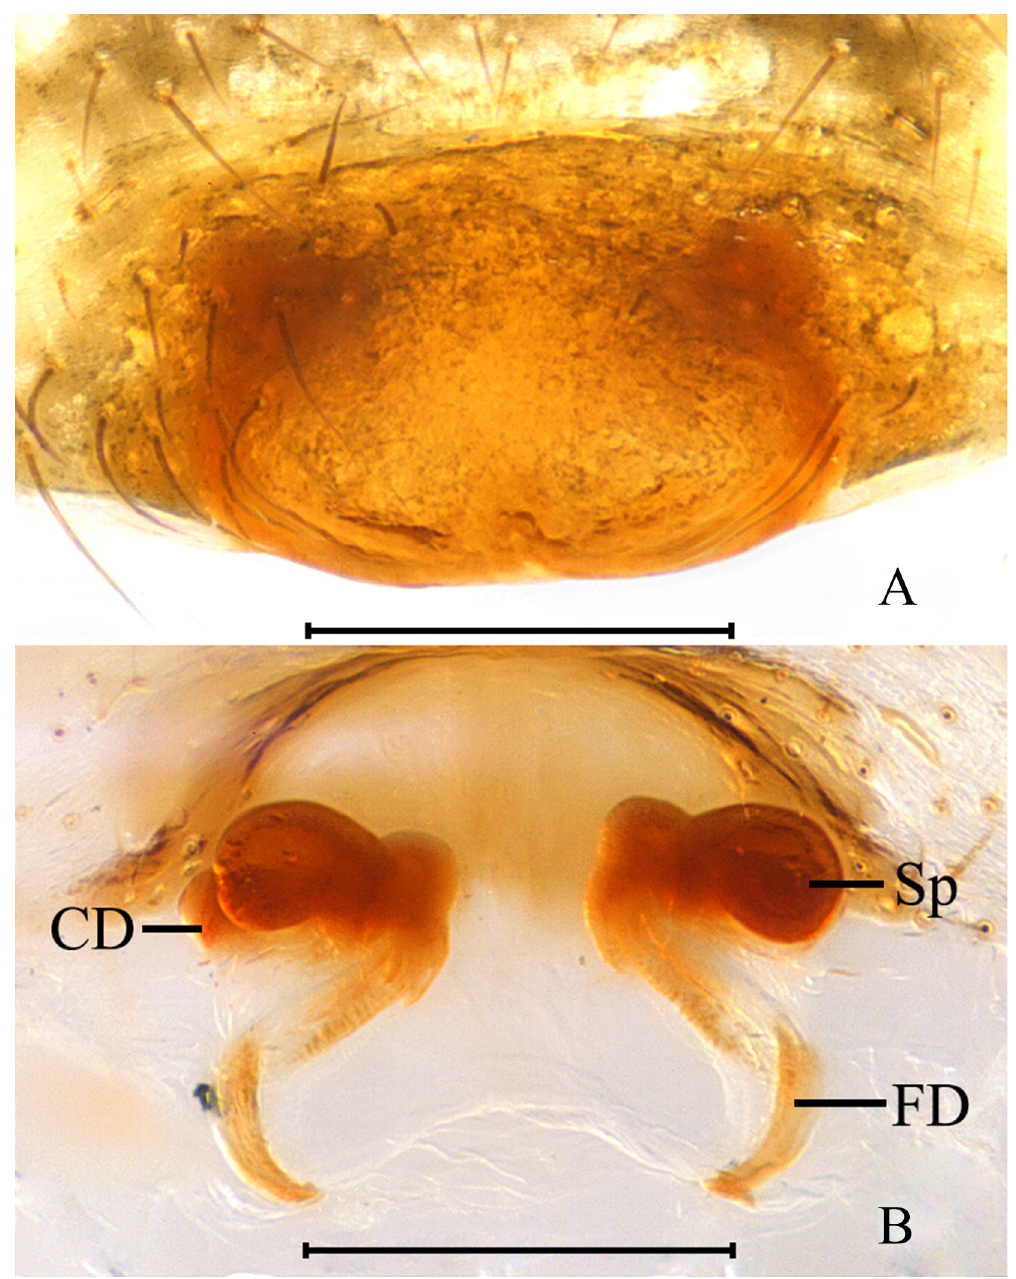
Fig. 11. Meta yani sp. nov. Paratype ♀ (HNU-Yan021004). A . Epigyne, ventral view. B . Vulva, front view. Scale bars: 0.2